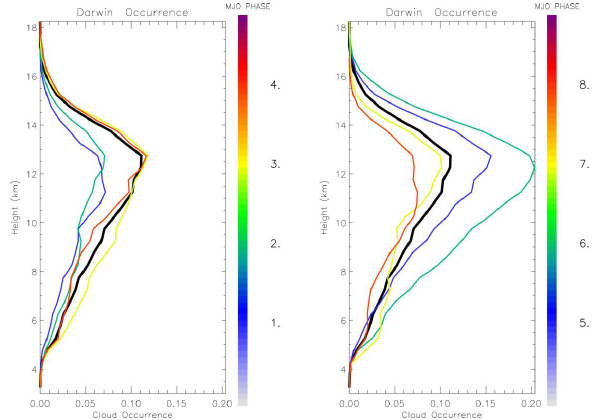
Figure 16: Same as Fig. 1 but for the MJO Phases : left panel for Phases 1 to 4, right panel for Phases 5 to 8. Colour code is given in the Figure.